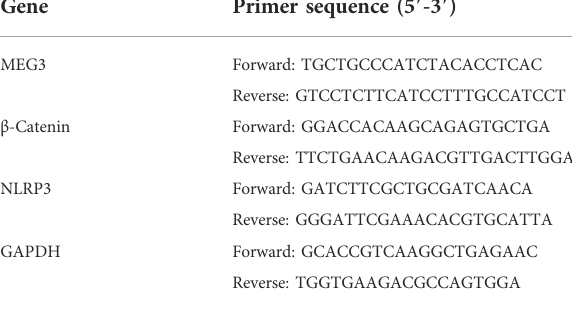
TABLE 2 Primer sequences for qRT ‒